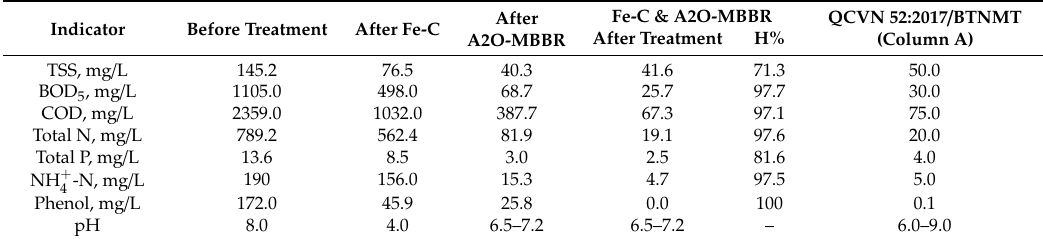
Table 4. Indicators of wastewater through di ff erent treatment